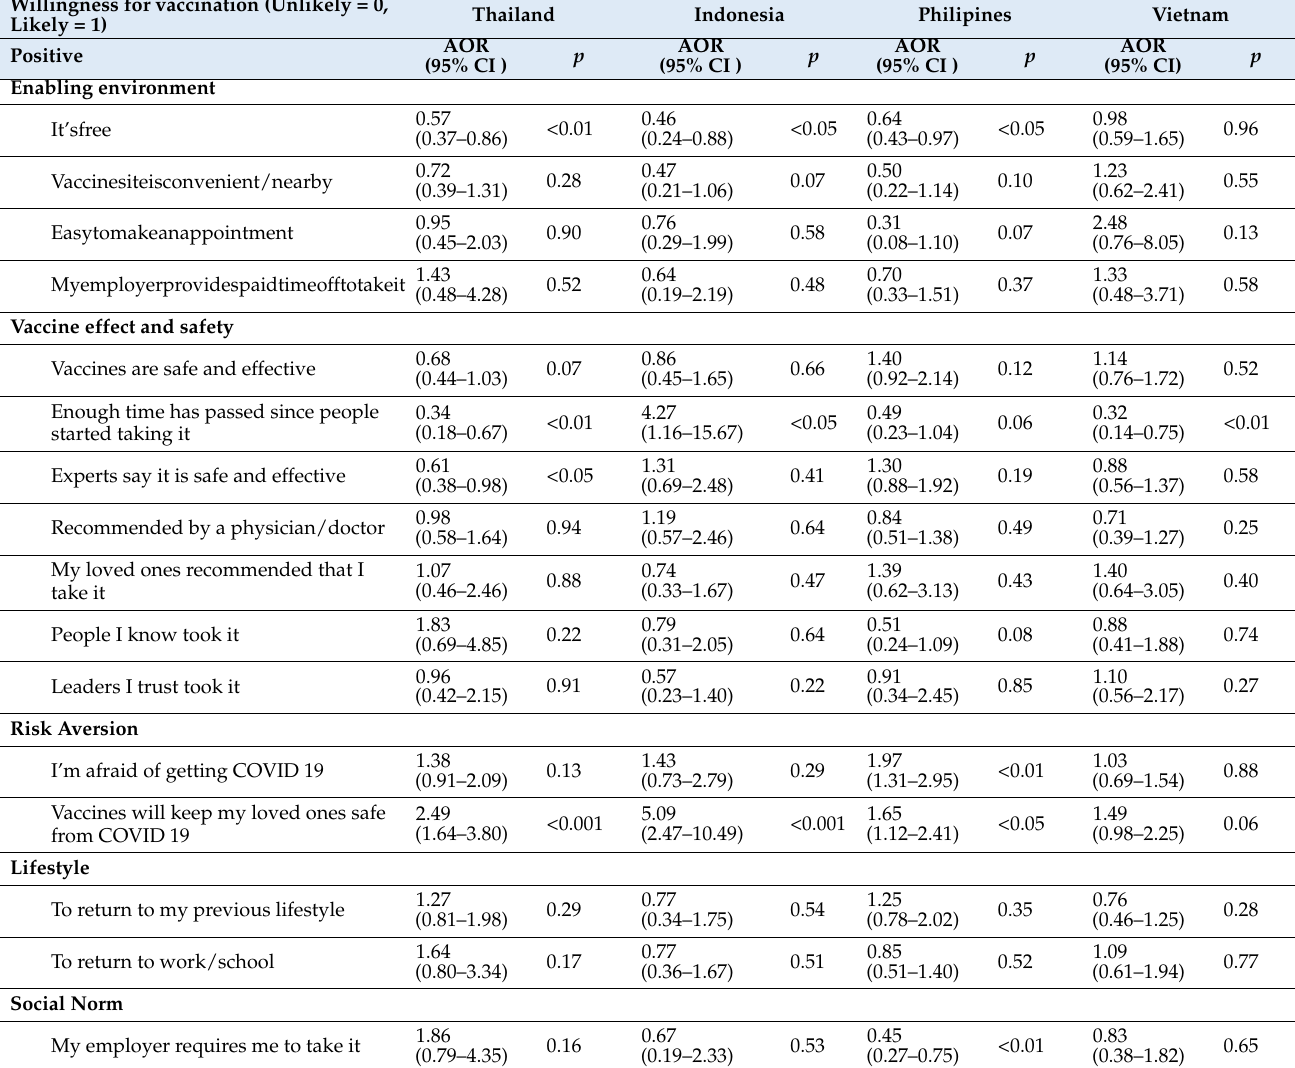
Table 10. Binomial logistic regression of willingness for vaccine with positive reasons (factor) to